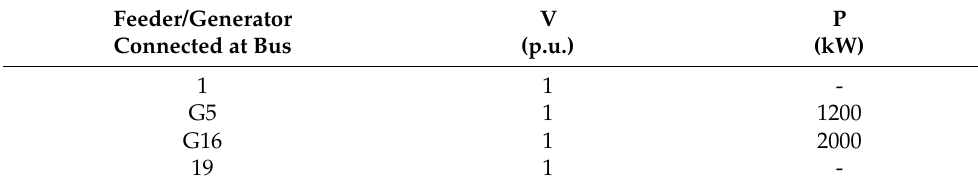
Table 1. Feeder/generator data.